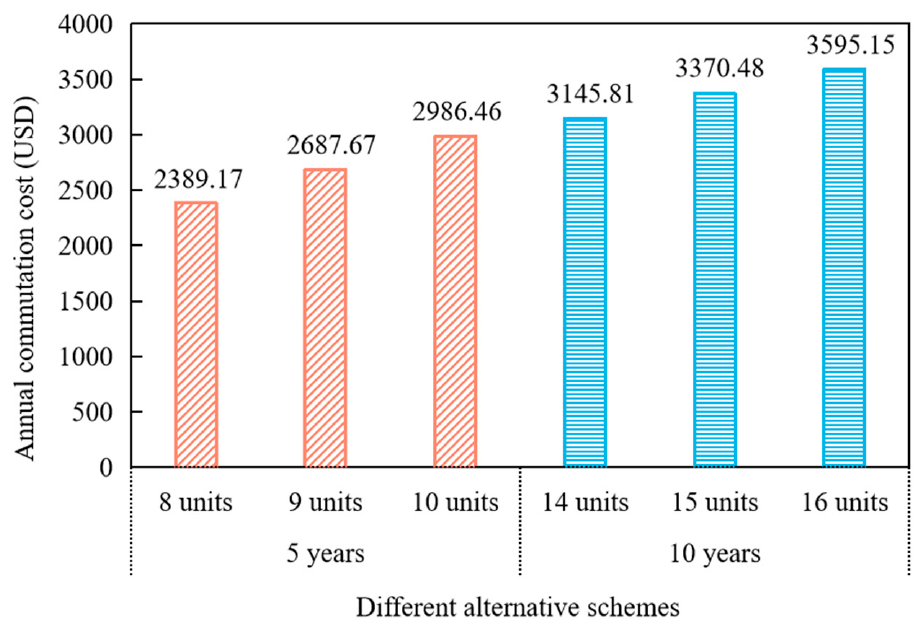
Figure 7. Comparison of annual commutation costs.